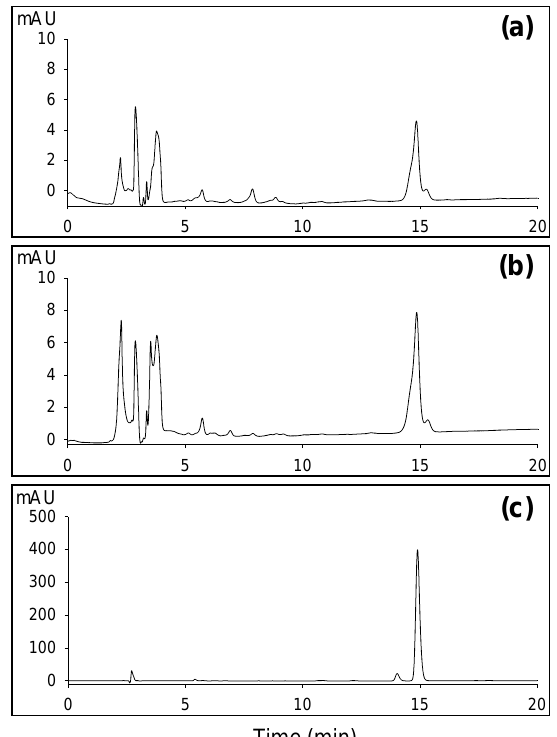
Figure 3. CHS activity assay of recombinant OsCHS8 ( a ) and OsCHS24 ( b ). The tetrahydroxychalcone was formed from p -coumaroyl-CoA and malonyl-CoA by OsCHS8 and OsCHS24. The resulting chalcone was spontaneously converted to naringenin, which was analyzed by reversed-phase HPLC. ( c ) HPLC chromatogram of the authentic